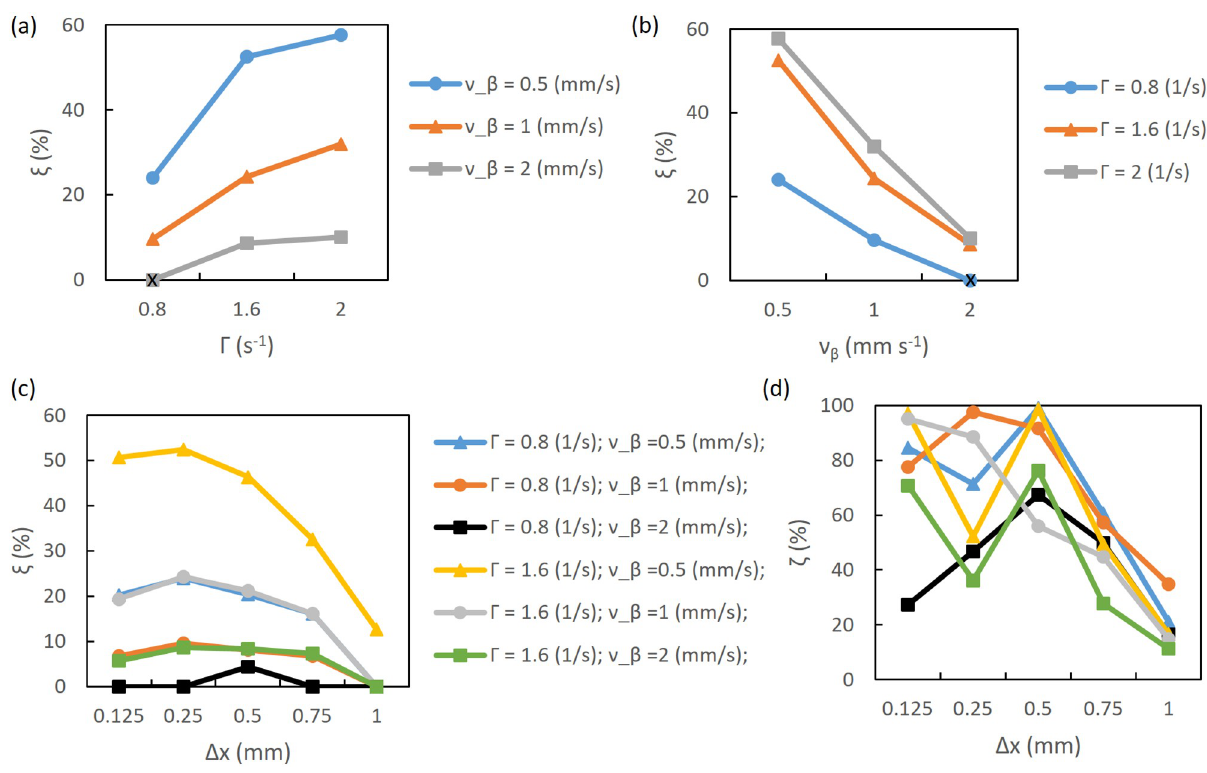
Fig 9. Modulation of noisy BOLD-Wiener from results in Fig 8(b) and modulation of corresponding deconvolved neural activity; OP of 0˚. (a) Modulation as a function of Γ , varying ν β (as shown in the legend), at a resolution of 0.25 mm. (b) Modulation as a function of ν β , varying Γ (as shown in the legend), at a resolution of 0.25 mm. (c) and (d) Modulation as a function of resolution for various Γ and ν β , as shown in the legend; (c) noisy BOLD-Wiener and (d) corresponding deconvolved neural activity. The black symbols represent results for the default case.